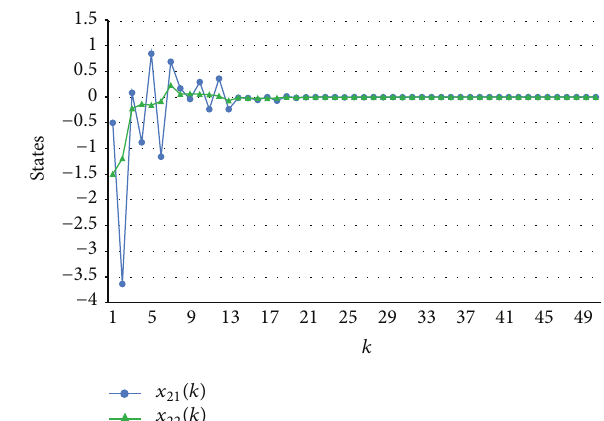
Figure 2: States respond of subsystem 2, 𝑥 21 (𝑘) and 𝑥 22 (𝑘) under discrete-time integral VSC.